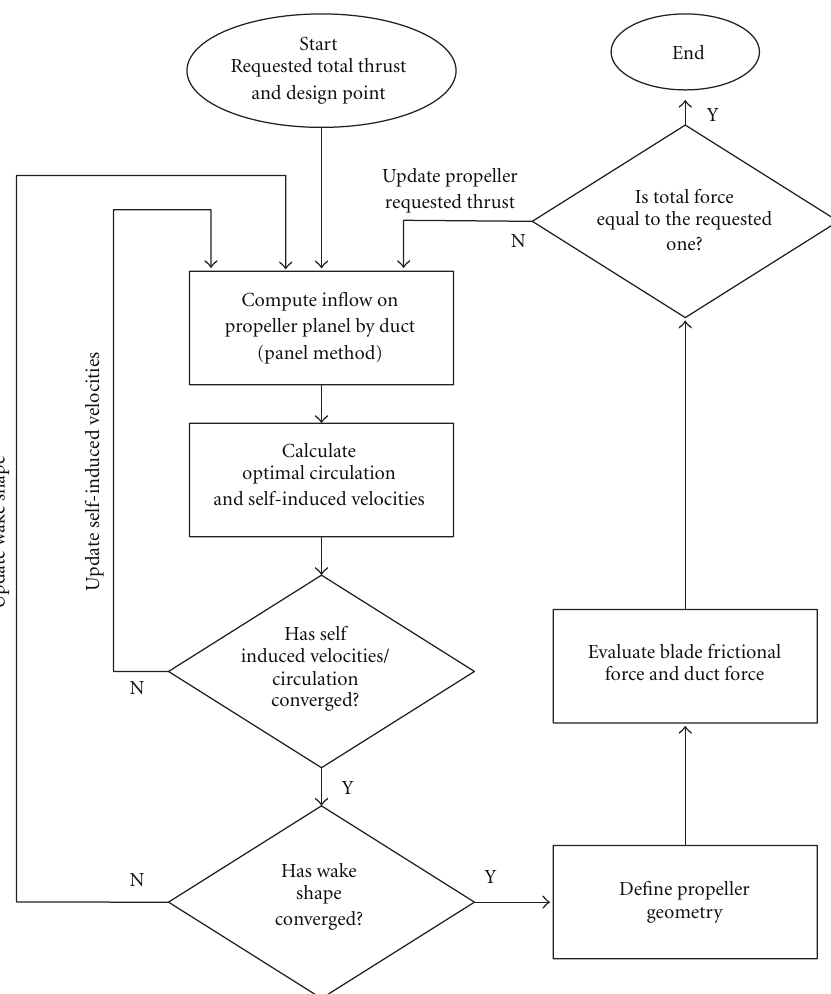
Figure 2: Flow chart for the coupled lifting line/panel method design approach.